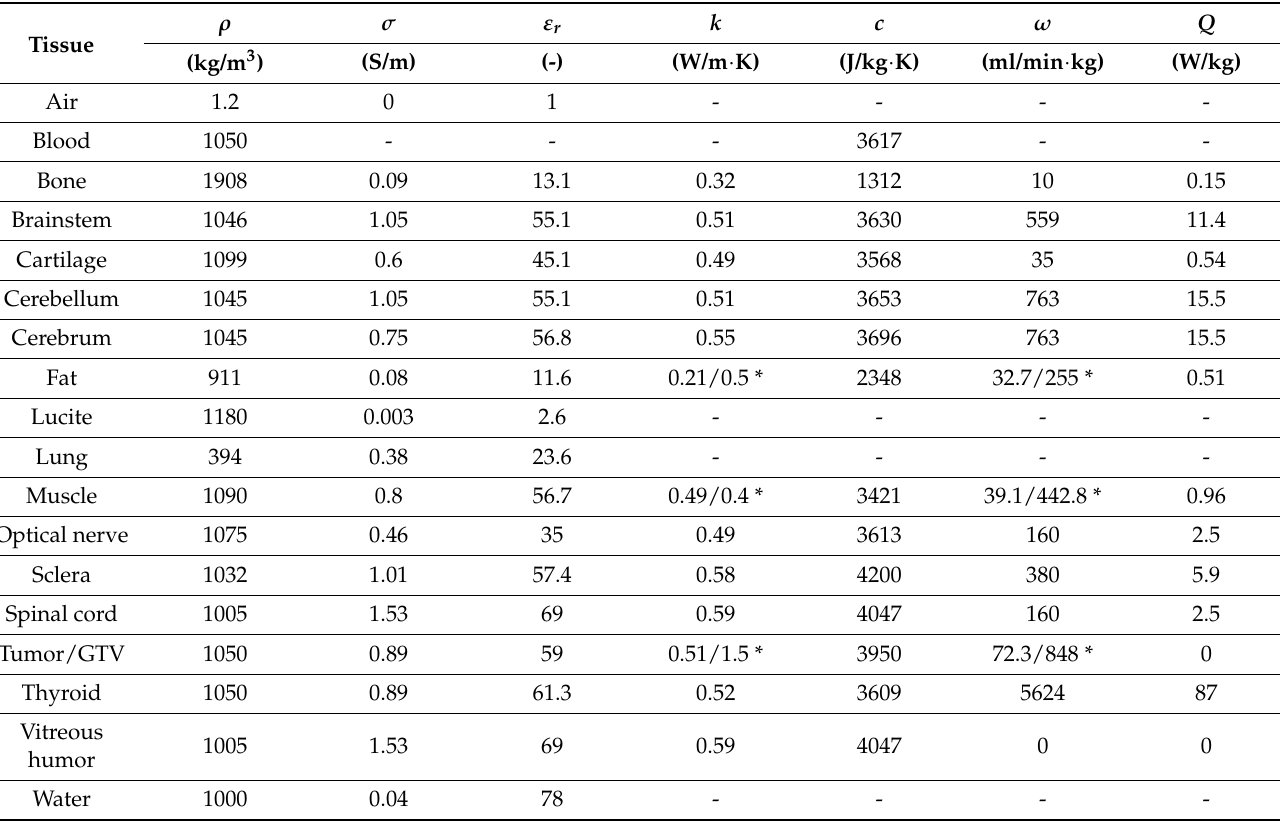
Table 1. Dielectric properties at 434 MHz [13], thermal properties for 37 ◦ C [14], * optimized values from ten patients treated with HYPERcollar applicator [15], the lung and internal air were in temperature simulations inactive and modeled using temperature boundary conditions. The values for tumor blood perfusion of 72.3 (mL min − 1 kg − 1 ) was obtained by scaling muscle perfusion by factor of 1.85 following muscle-tumor difference at 37 ◦ C from